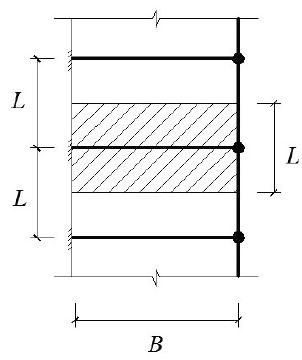
Figure 9. Creating a structural layout of the cross beam and column type plank road.